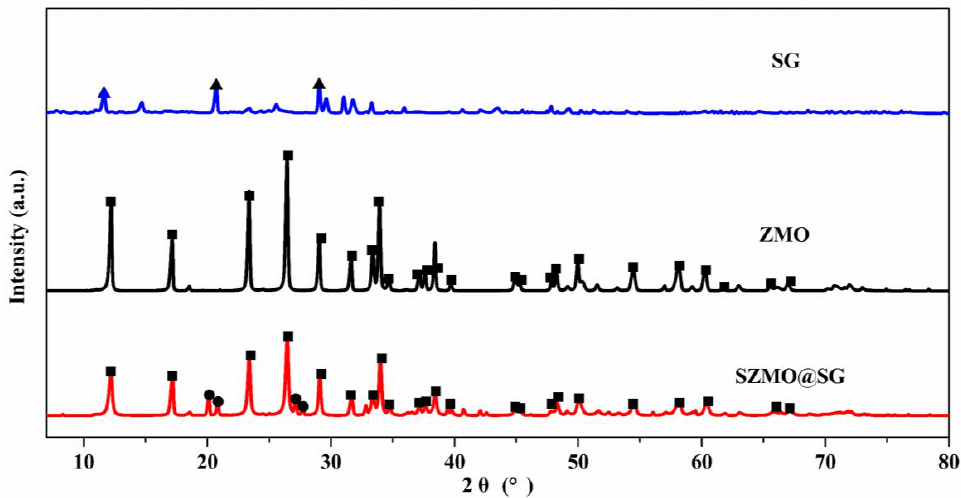
Figure 4. XRD patterns for SG, ZMO and SZMO@SG. (The characteristic peak of SG, ZMO and SZMO@SG are marked with symbols)